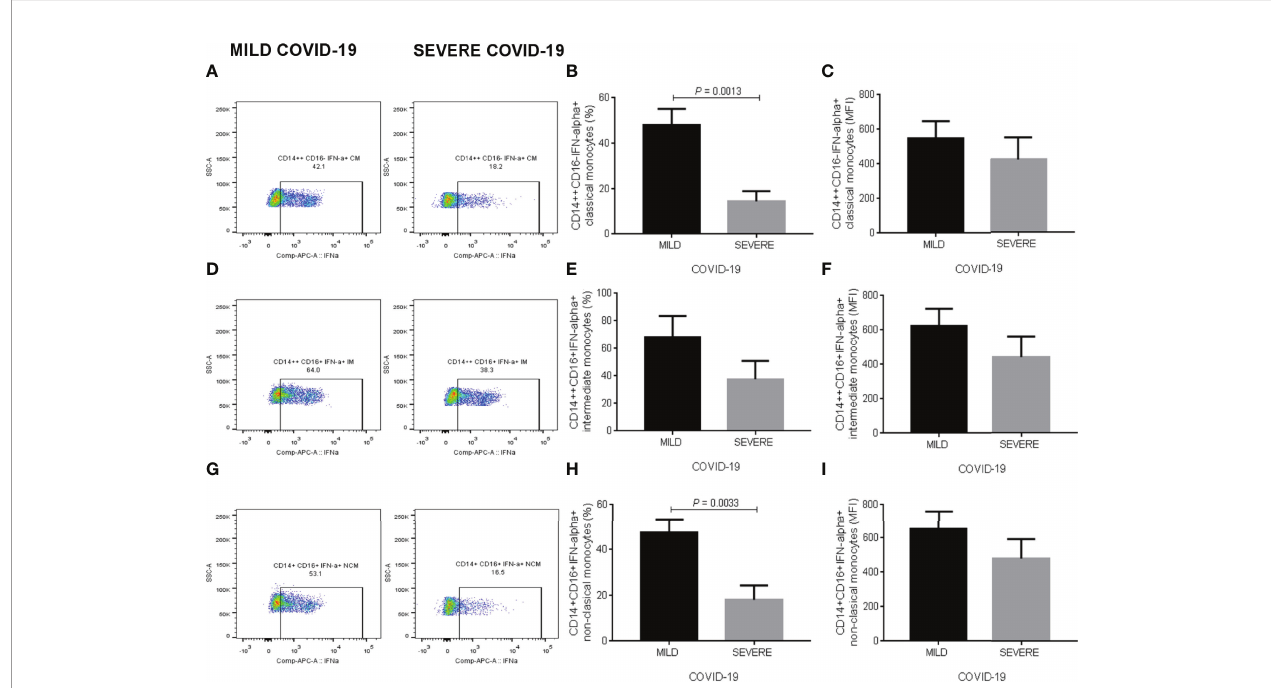
FIGURE 4 | IFN-alpha expression in classical, intermediate, and non-classical monocyte subpopulations in response to polyclonal stimuli in vitro . (A) Representative dot-plots illustrating the comparison of CD14++CD16- classical monocytes expressing IFN-alpha in blood samples treated with polyclonal stimuli from participants who developed mild or severe COVID-19 during the follow-up. (B) Percentage of CD14++CD16- classical monocytes expressing IFN-alpha. (C) Mean fl uorescence intensity of IFN-alpha in CD14++CD16- classical monocytes. (D) Representative dot-plots exemplifying the contrast of CD14++CD16+ intermediate monocytes expressing IFN-alpha in whole blood samples exposed to polyclonal molecules from participants who experienced mild or severe COVID-19 throughout the follow- up. (E) Percentage of CD14++CD16+ intermediate monocytes expressing IFN-alpha. (F) Mean fl uorescence intensity of IFN-alpha in CD14++CD16+ intermediate monocytes. (G) Representative dot-plots illustrating the comparison of CD14+CD16+ non-classical monocytes expressing IFN-alpha in blood samples treated with polyclonal stimuli from participants who developed mild or severe COVID-19 during the follow-up. (H) Percentage of CD14+CD16+ non-classical monocytes expressing IFN-alpha. (I) Mean fl uorescence intensity of IFN-alpha in CD14+CD16+ non-classical monocytes. Prior to infection, we obtained whole blood samples from all participants enrolled in the study and cultured them with polyclonal stimuli, including poly I:C, SARS-CoV-2 recombinant spike S1 protein, and LPS, for two hours. We then acquired monocyte cells on a BD FACS Canto II Flow Cytometer, acquiring 10,000 events per test in triplicate and storing data until a participant got SARS-CoV-2 infection. Upon infection and depending on the clinical course of the disease, we analyzed fl ow cytometry data as part of the mild or severe COVID-19 groups. Black bars represent the mild COVID-19 group. Gray bars represent the severe COVID-19 group. We expressed data as mean ± standard deviation. We compared data using the unpaired Student ’ s T-test and considered differences signi fi cant when P < 0.05. We de fi ned classical monocytes as CD14++CD16-, intermediate monocytes as CD14++CD16+, and non-classical monocytes as CD14+CD16+. IFN-alpha, interferon-alpha; MFI, mean fl uorescence intensity; COVID-19, coronavirus disease 2019, LPS, lipopolysaccharide; SARS-CoV-2, severe acute respiratory syndrome coronavirus type